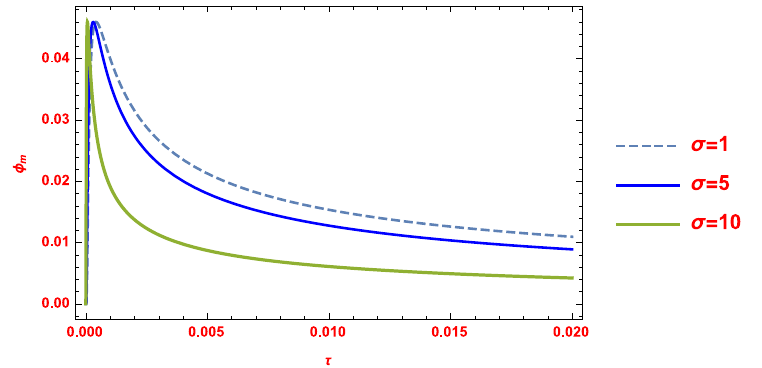
Figure 13. φ m varying along τ for different σ